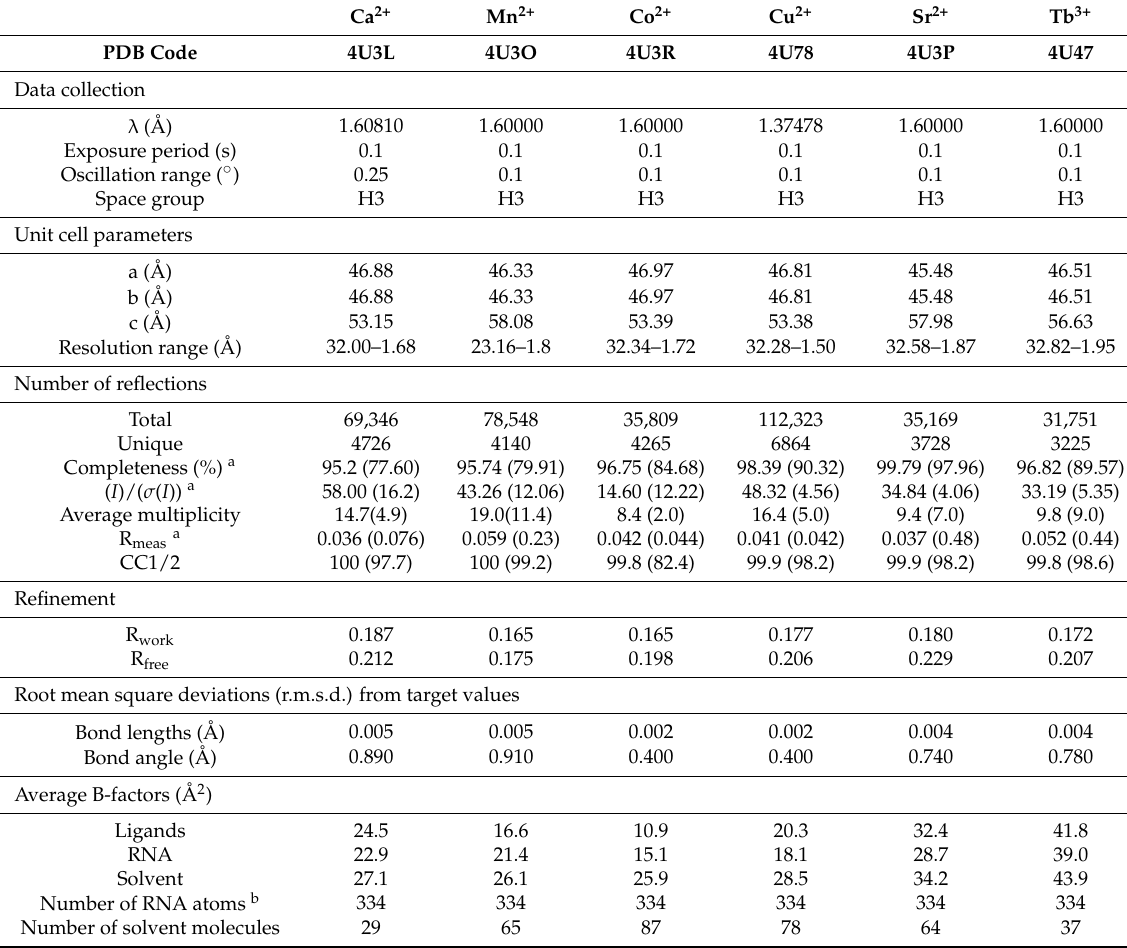
Table 3. Statistics of data collection and refinement of the octamer in the presence of the indicated divalent metal